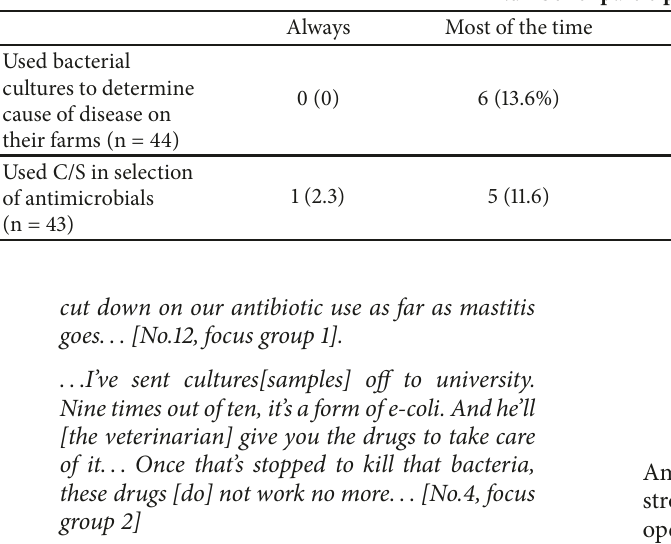
Number of participants (percentage) Yes Not sure No 28 (70) 4 (10) 8 (20) 9 (22.5)